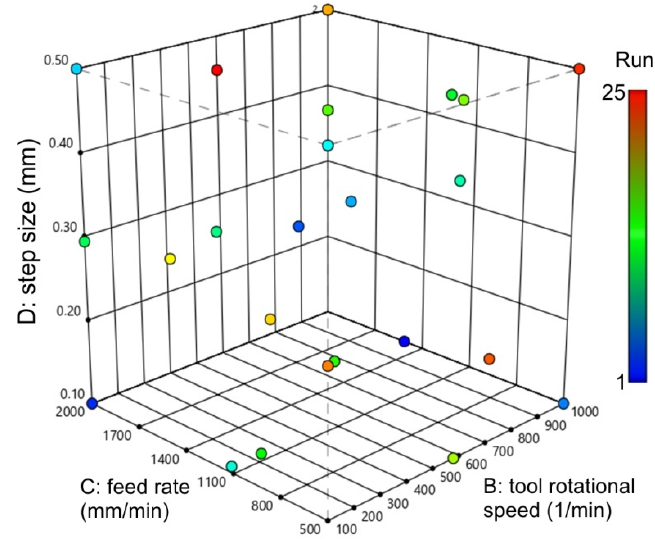
Figure 5. Points of the split-plot I-optimal design in the workspace.